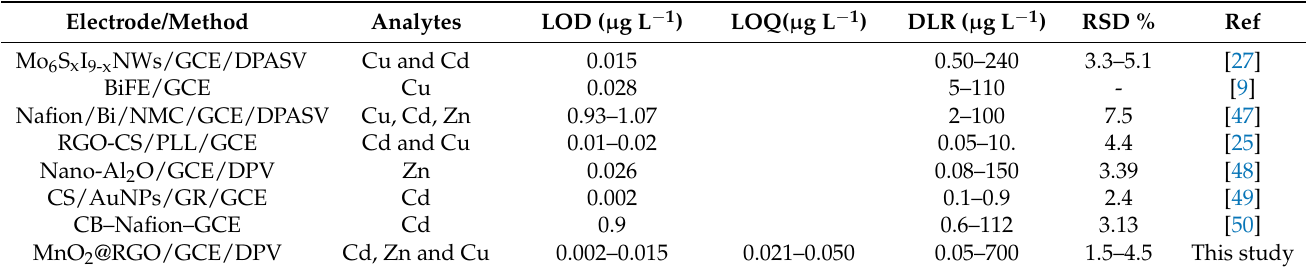
Table 3. Comparison of analytical parameters of the different modified electrodes reported for the determination of Cd, Cu, and Zn ions.